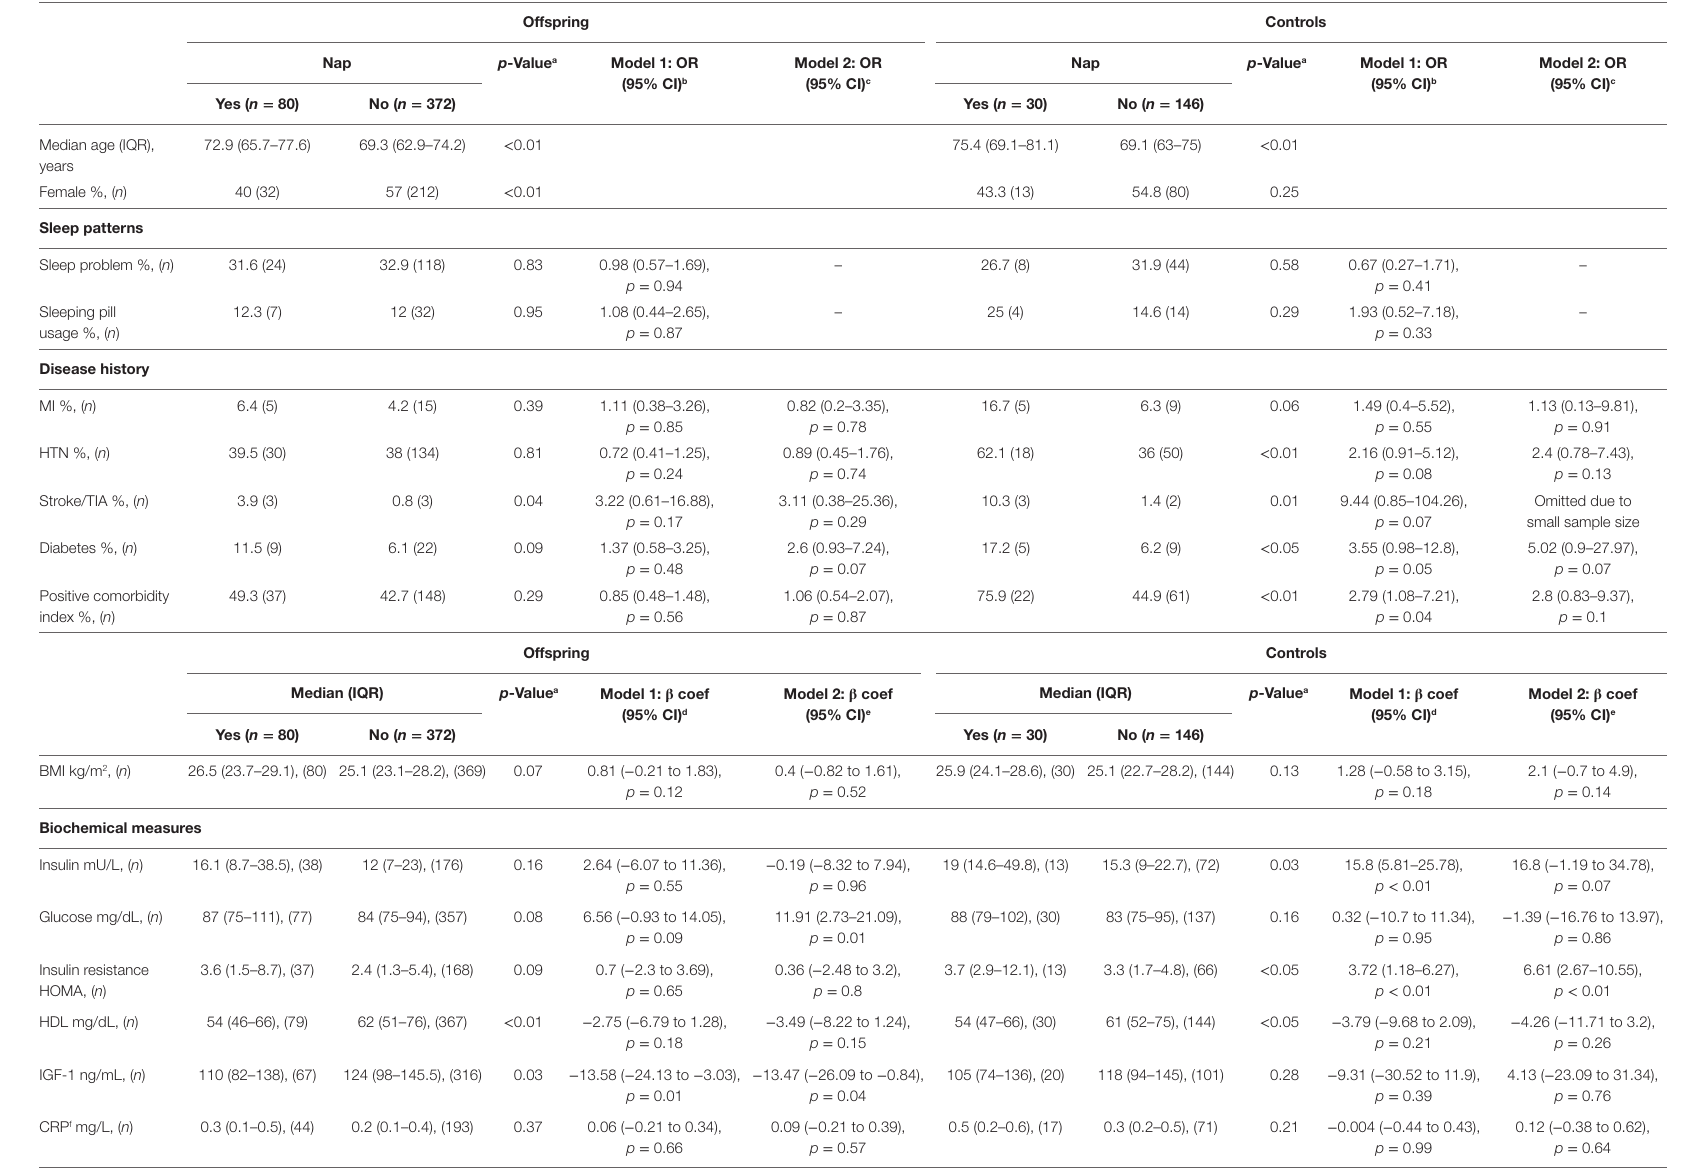
TaBle 4 | Associations between napping behavior and disease or biochemical profile for offspring and